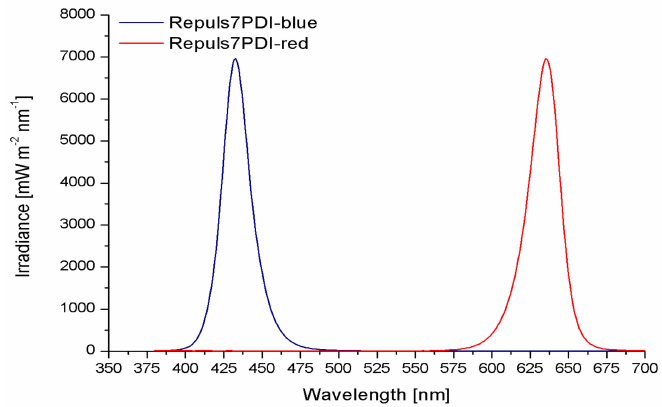
Figure 2. Irradiance spectrum of the Repuls7PDI-blue and the Repuls7PDI-red. The Repuls7PDI-blue shows a distinct irradiance peak at 433 nm (blue line) and the Repuls7PDI-red (red line) peaks at 635